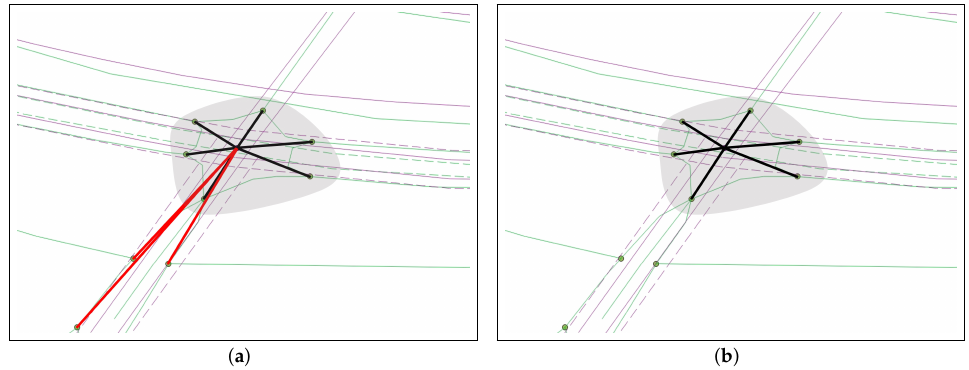
Figure 15. Example of node clustering in the ( a ) RWM-DG and ( b ) AP